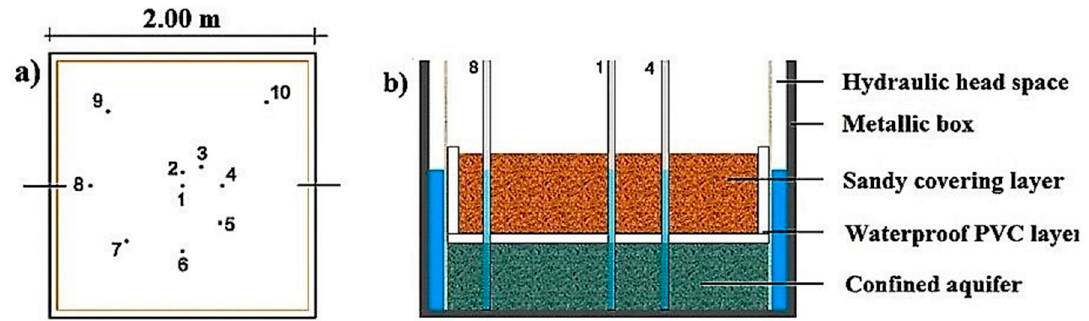
Figure 1. ( a ) Planimetric scheme of the metal box in which the confined aquifer was built, with the location of the ten wells (numbered from 1 to 10). ( b ) Section of the metal box with the associated stratigraphic schemes.